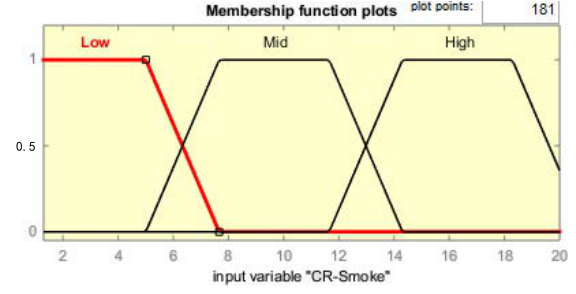
Figure 12. MF plot for Smoke.